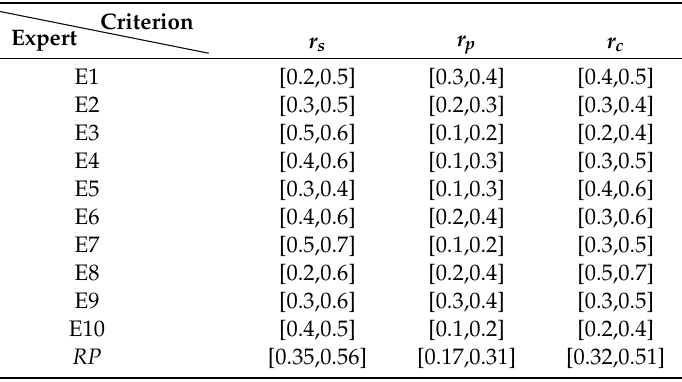
Figure 4. Details of the underground power station. Table 2. Evaluation results given by